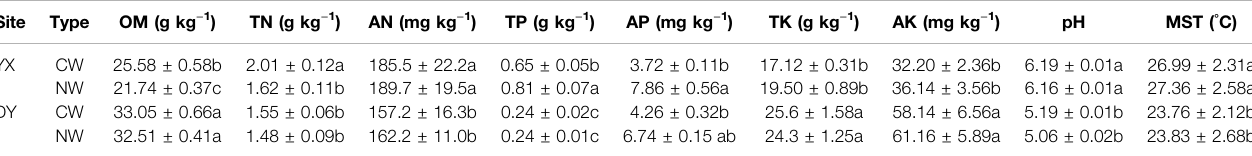
TABLE 1 | Soil physical and chemical properties (mean ± SD, n (cid:2) 3) in paddy fi elds at the two experimental sites in Hubei Province, China. Site